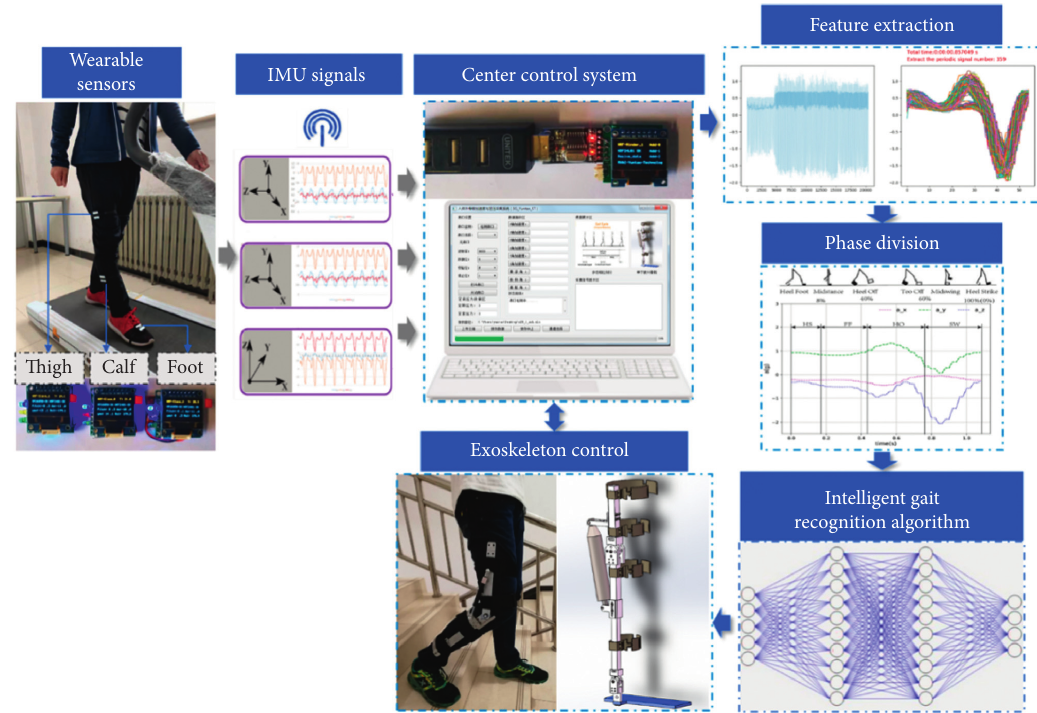
Figure 2: Human gait information acquisition